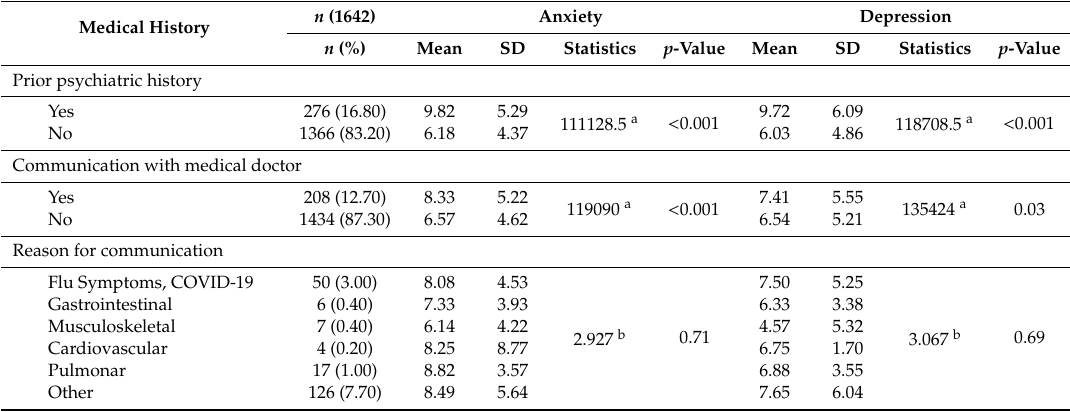
Table 2. Relationship between Medical History variables with anxiety and depression